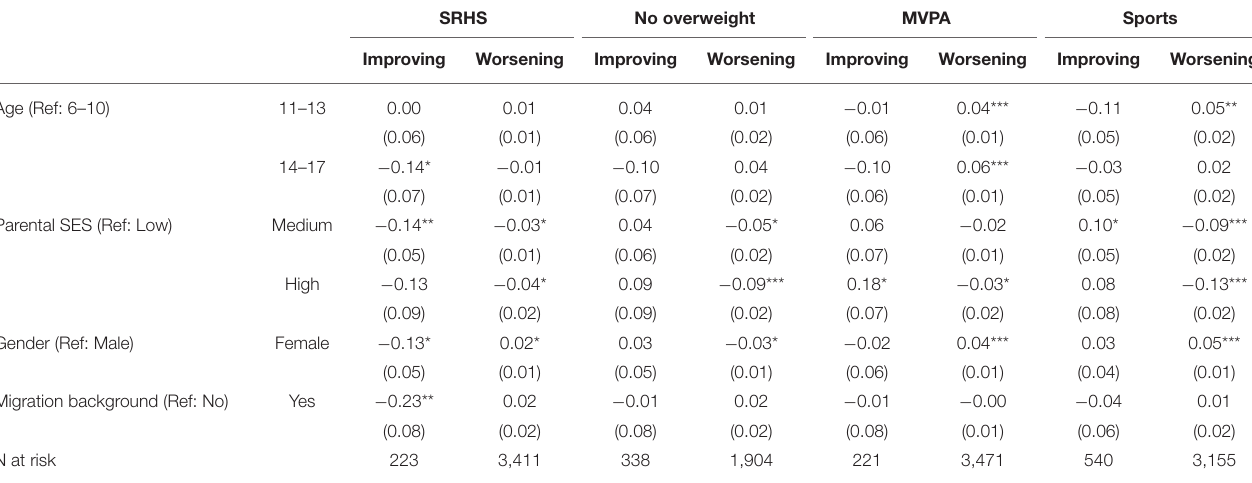
TABLE 4 | Logistic regression of the health status and PA indicators, differentiated by improving and worsening (average marginal effects). SRHS No overweight MVPA Sports Improving Worsening Improving